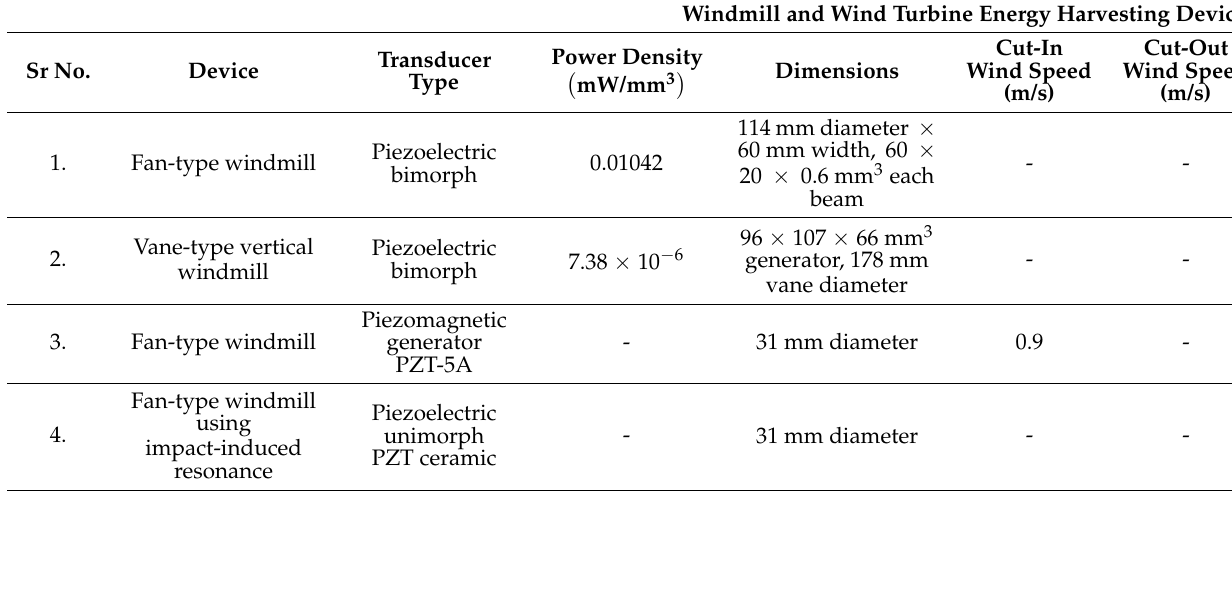
Table 1. Piezoelectric Devices in Wind